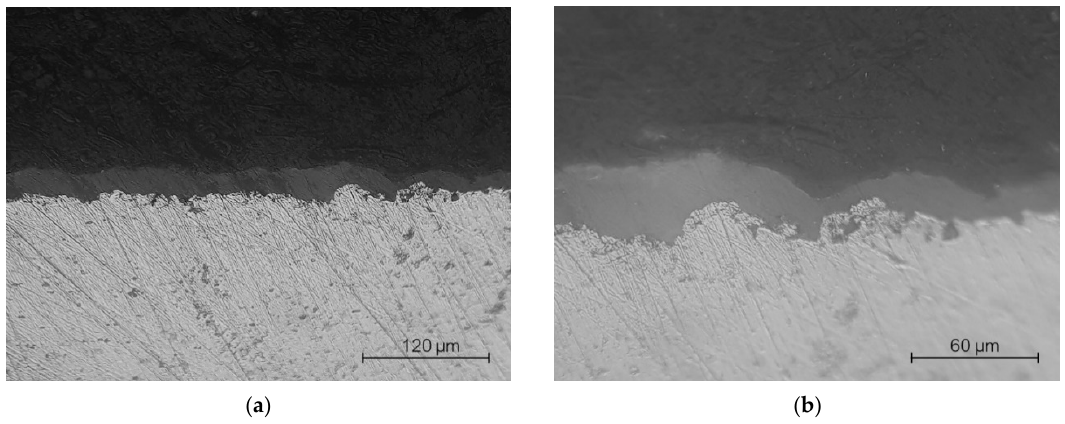
Figure 7. Microscopic image of the test specimen cross section after testing, showing the changes in thickness at different magnifications: ( a ) layer view with a magnification of 20 × ; ( b ) layer view with a magnification of 40 ×